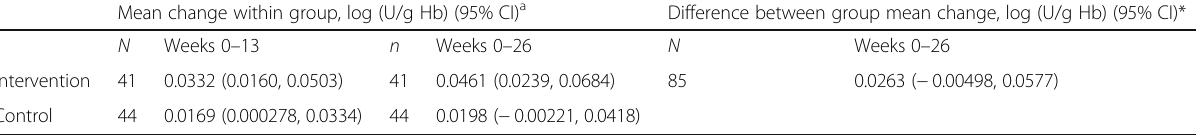
Table 2 Changes within groups and differences between group changes in erythrocyte GPX enzyme